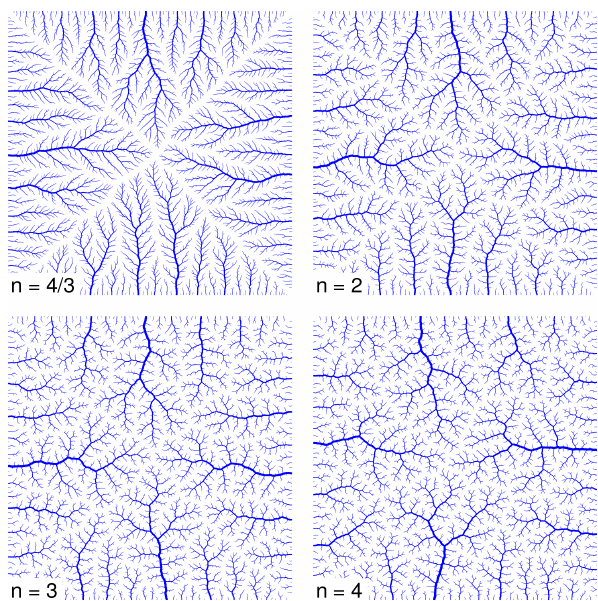
Figure 1. Dendritic flow patterns obtained by numerical optimiza- tion for different values of n on lattices of 4096 × 4096 sites. Only flow paths with a discharge of at least 10 − 5 of the total recharge are plotted. The line width is proportional to the third root of the discharge, which is proportional to the diameter of the conduits for n = 2.